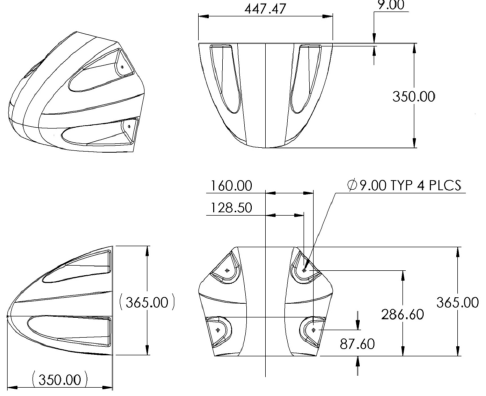
Figure 1. Geometry of Brookes XII carbon fiber reinforced composite (CFRP) nose cone